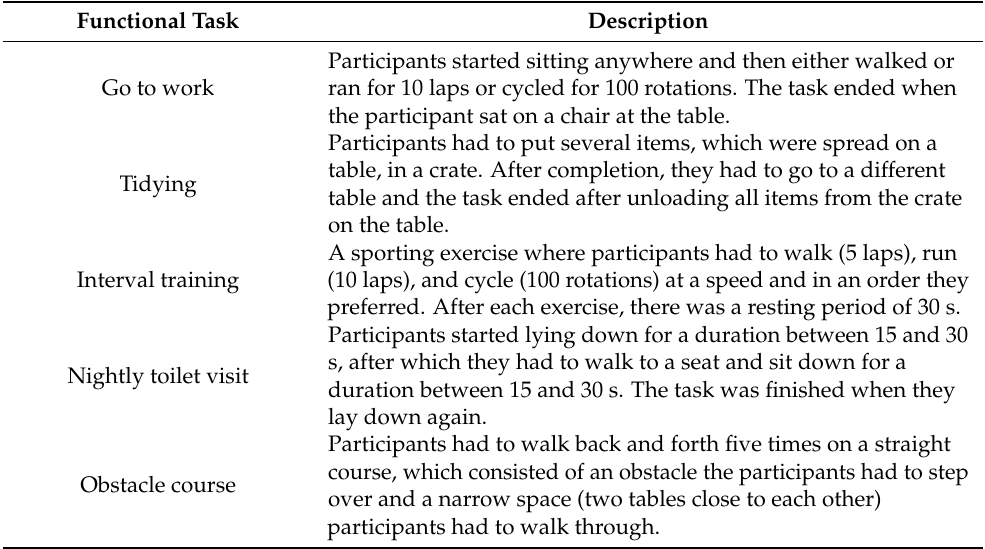
Table 3. Description of the functional tasks that were all performed once.